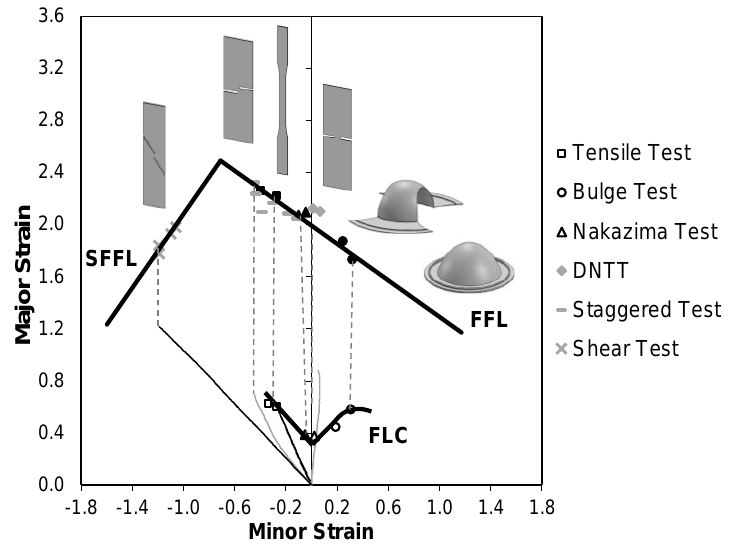
Figure 8. Failure loci (FLC, FFL and SFFL) of copper sheets with 1 mm thickness. The solid and open markers correspond to strains at fracture and necking, respectively.